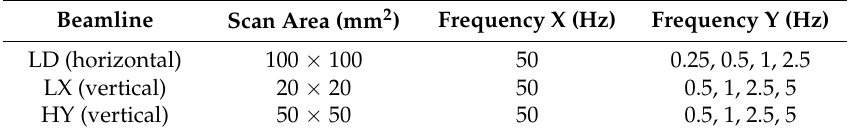
Table 4. Specification of the beam scanner. Irradiation uniformity in the scan area is less than 10%.